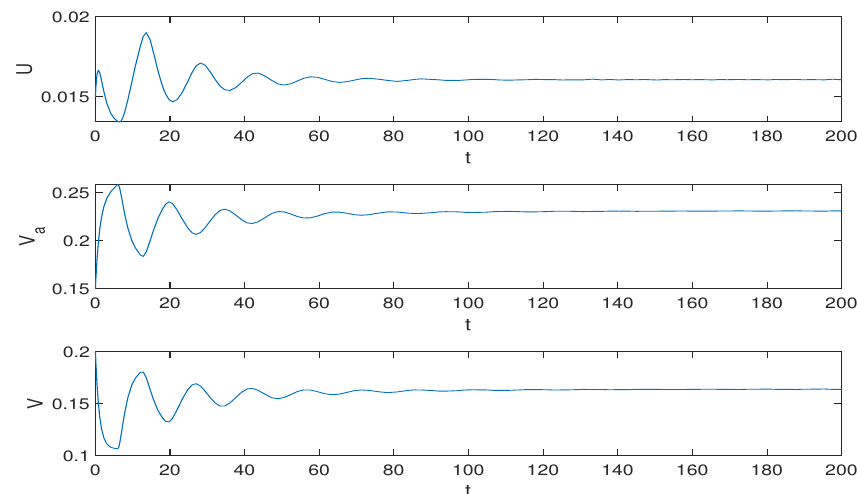
Figure 4. When τ = 4, the equilibrium P of system (1) is locally asymptotically stable.